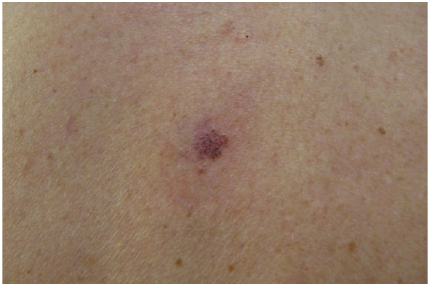
Figure 1: Crusty pigmented lesion located in the dorsal region.